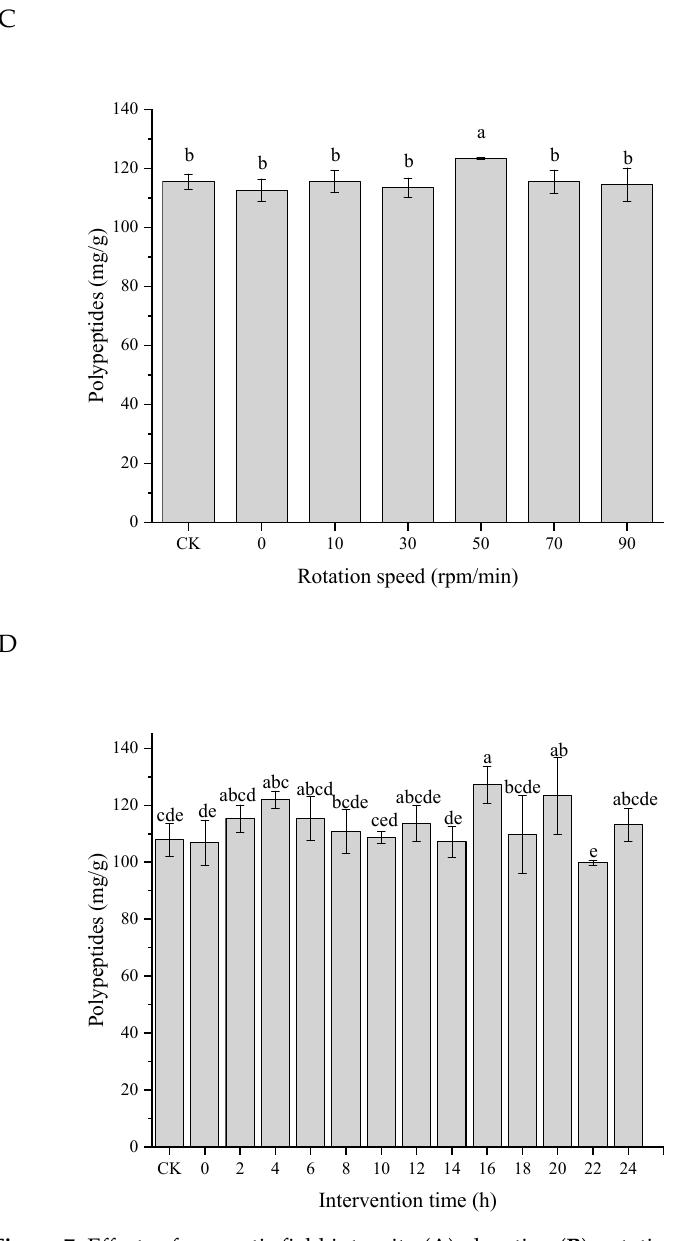
Figure 7. Effects of magnetic field intensity ( A ), duration ( B ), rotation speed ( C ), and initiation time of intervention ( D ) on polypeptide production by LF-MF assisted fermentation. Bars with different letters differ significantly ( p < 0.05).